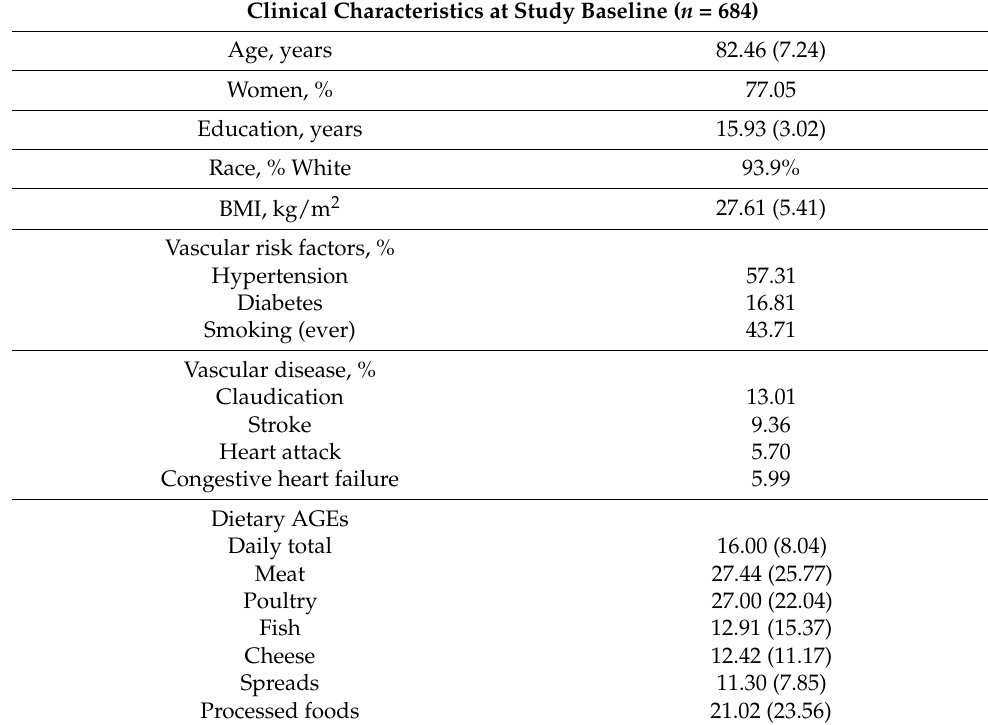
Table 1. Clinical Characteristics at Study Baseline ( n =